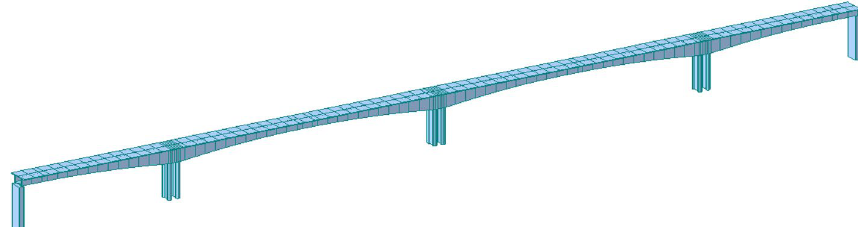
Fig. 14 3D FE model of Girga Bridge in Civil Midas software